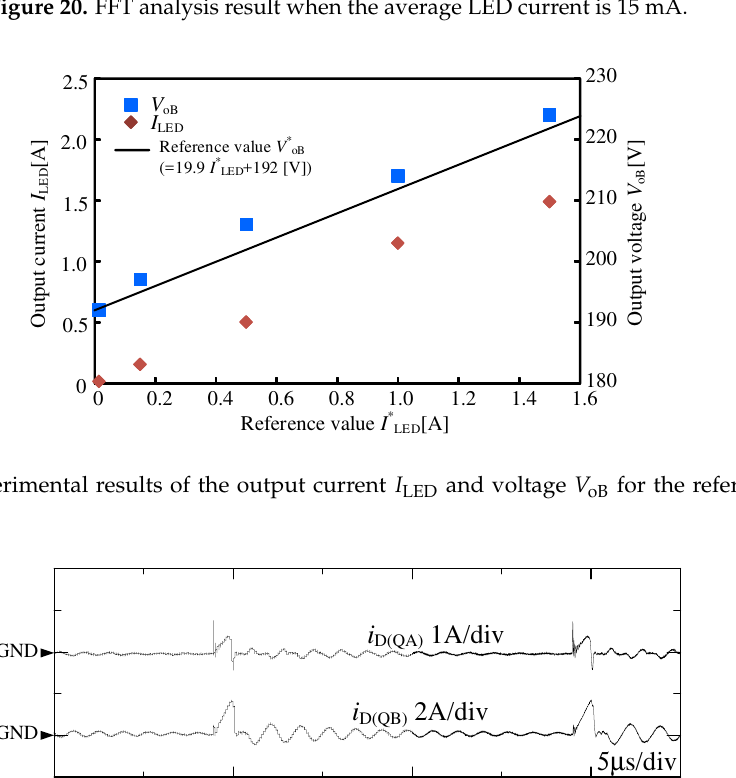
Figure 22. Experimental results of the proposed cooperative control method when the reference LED current I ∗ is 15 LED